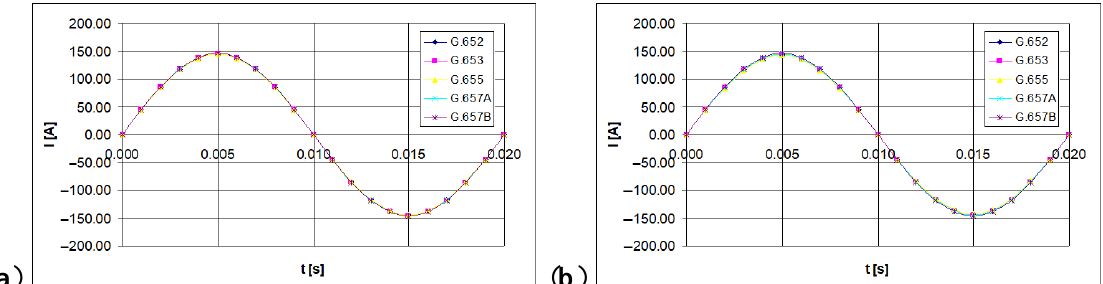
Figure 3. The time waveform measured with forced RMS current value of 100 A, depending on the single mode telecommu- nications fiber standard [own results]: ( a ) for 40-turns measuring coil and ( b ) for 80-turns measuring coil.